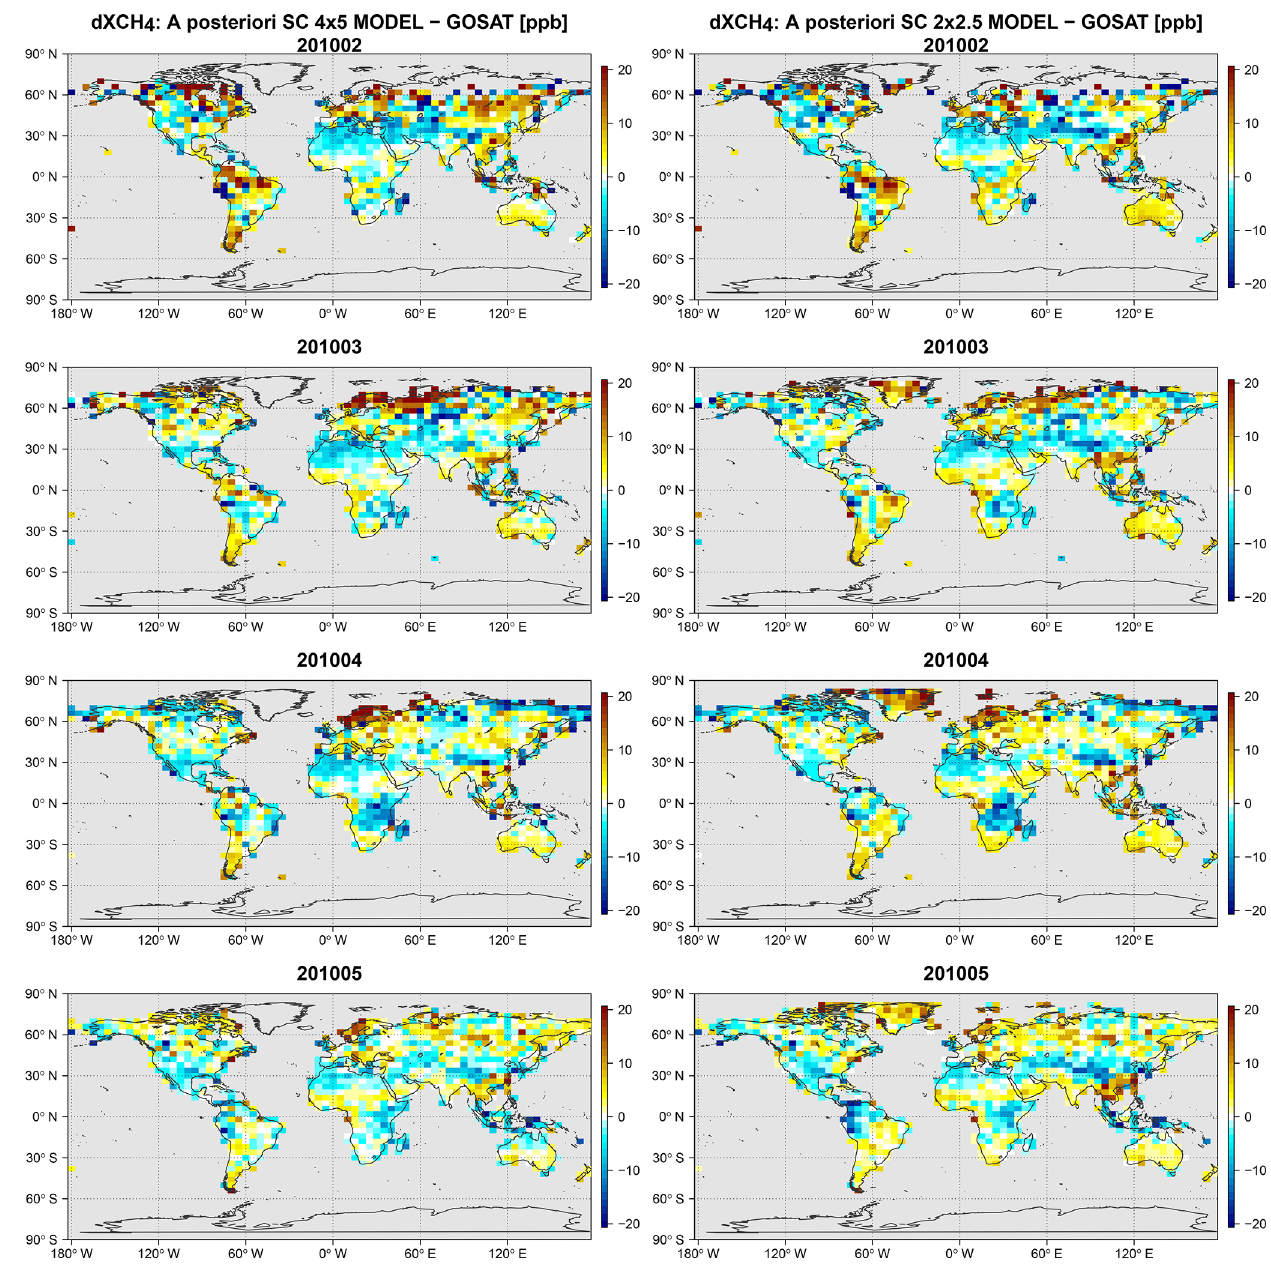
Figure 8. Monthly mean differences between the GEOS-Chem a posteriori XCH 4 state and GOSAT. Left column: differences between the a posteriori state from the SC flux assimilation at 4 ◦ × 5 ◦ (SC_4x5) and GOSAT. Right column: differences between the a posteriori state from the SC flux assimilation at 2 ◦ × 2.5 ◦ (SC_2x25) and GOSAT. The rows represent results for (top row) February, (second row) March, (third row) April, and (bottom row) May